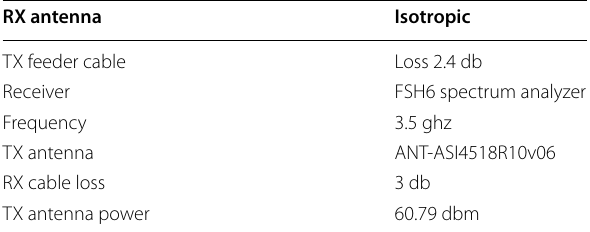
Table 3 Measurement configurations